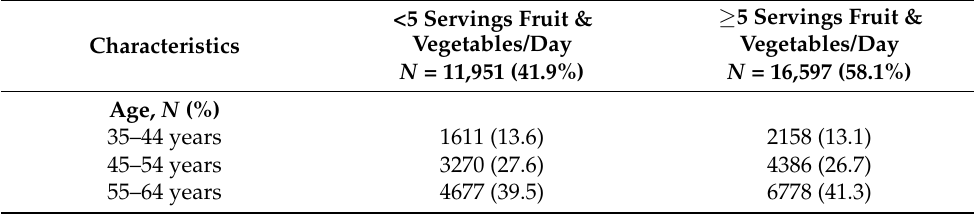
Table 1. Characteristics of the BCGP cohort sample 1